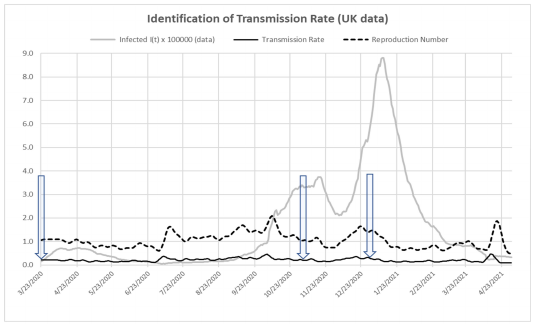
Figure 4. The identified transmission rate β ( t ) and reproduction number R t for COVID-19 epidemic in the UK in 2020-21. Three major lockdowns are indicated by arrows.